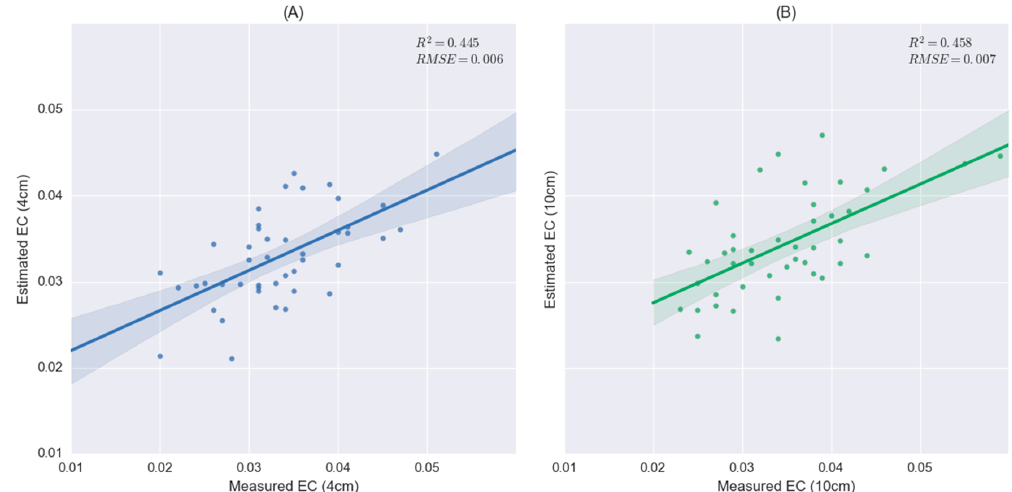
Figure 8. Regression plots between measured target values and estimated values before vegetation suppression for soil salinity at the depth of 4 cm ( A ) and 10 cm ( B ).